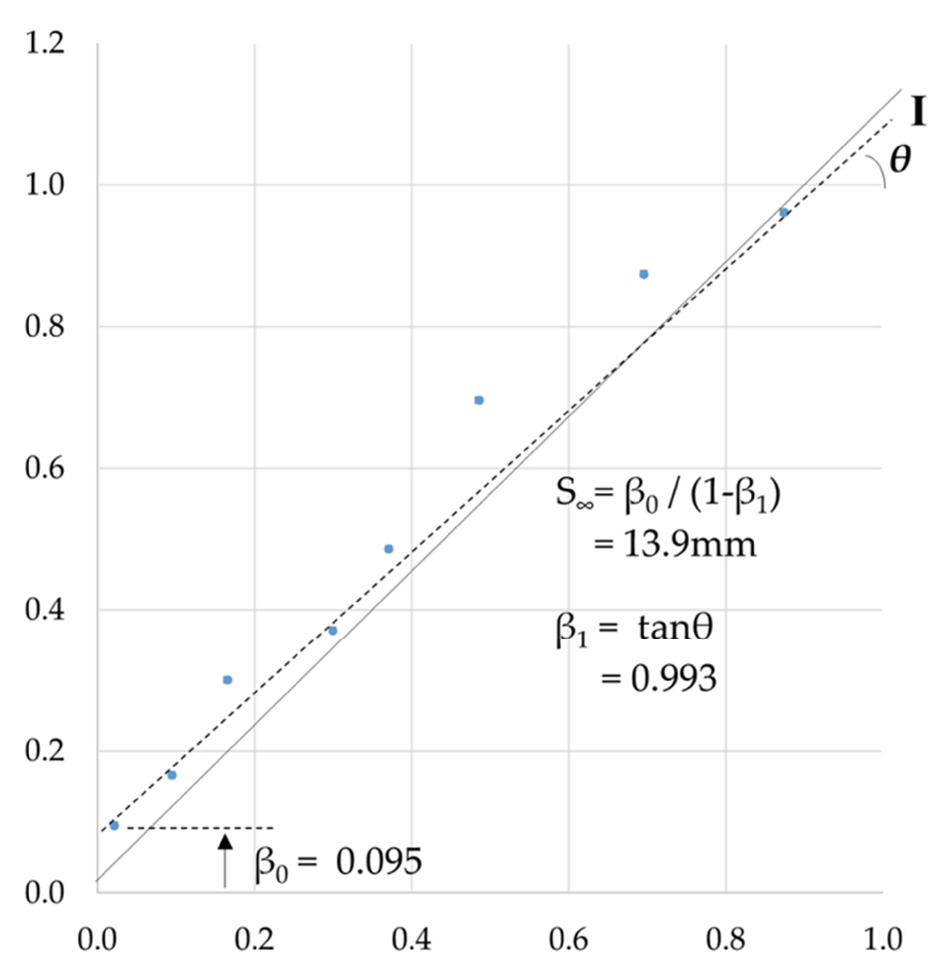
Figure 9. Long-term settlement predicted by Asaoka method